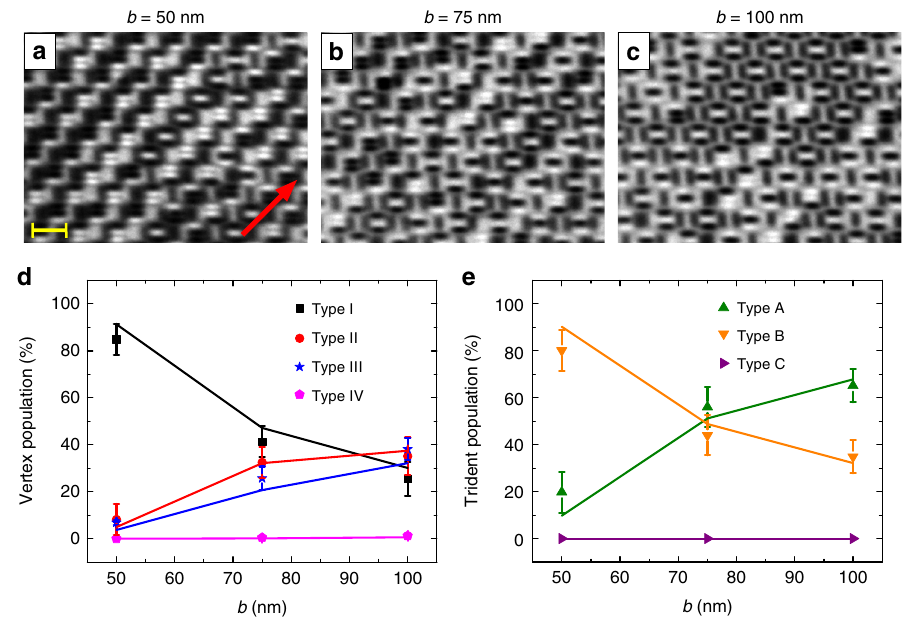
Fig. 3 Tuning geometrical frustration in dipolar trident lattice. a – c XMCD images of equilibrium con fi gurations of trident lattices with various lattice spacings ( a = 50 nm = const, b = 50, 75, and 100 nm) recorded at T = 300 K (blocking temperature T B = 310 K). The red arrow indicates the direction the X-ray propagation vector. The yellow scale bar indicates a length of 1 µ m. d Experimentally observed vertex-type population plotted as a function of lattice parameter b . e Trident-type population plotted with increasing lattice parameter b . Experimental observations ( fi lled symbols) are in satisfactory agreement with equilibrium Monte Carlo simulations (lines). The results reveal the transition from a Type I vertex and Type B trident-ordered state ( b = 50 nm), to a disordered con fi guration ( b = 75 nm) with no clear ordering preference, and, fi nally, to a Type A trident-ordered state ( b = 100 nm), as the lattice parameter b is increased. The error bars represent standard deviations originating from ten experimental observations